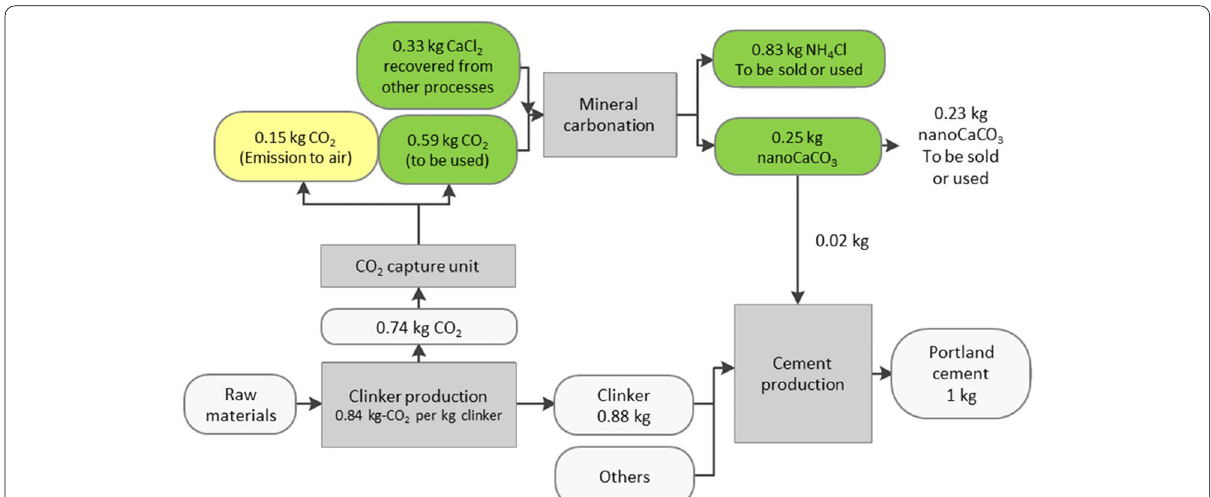
Fig. 10 Proposed production of cement with the utilization of calcium carbonate produced from the sequestration of CO 2 via indirect carbonation (Reproduced from [128] with permission from